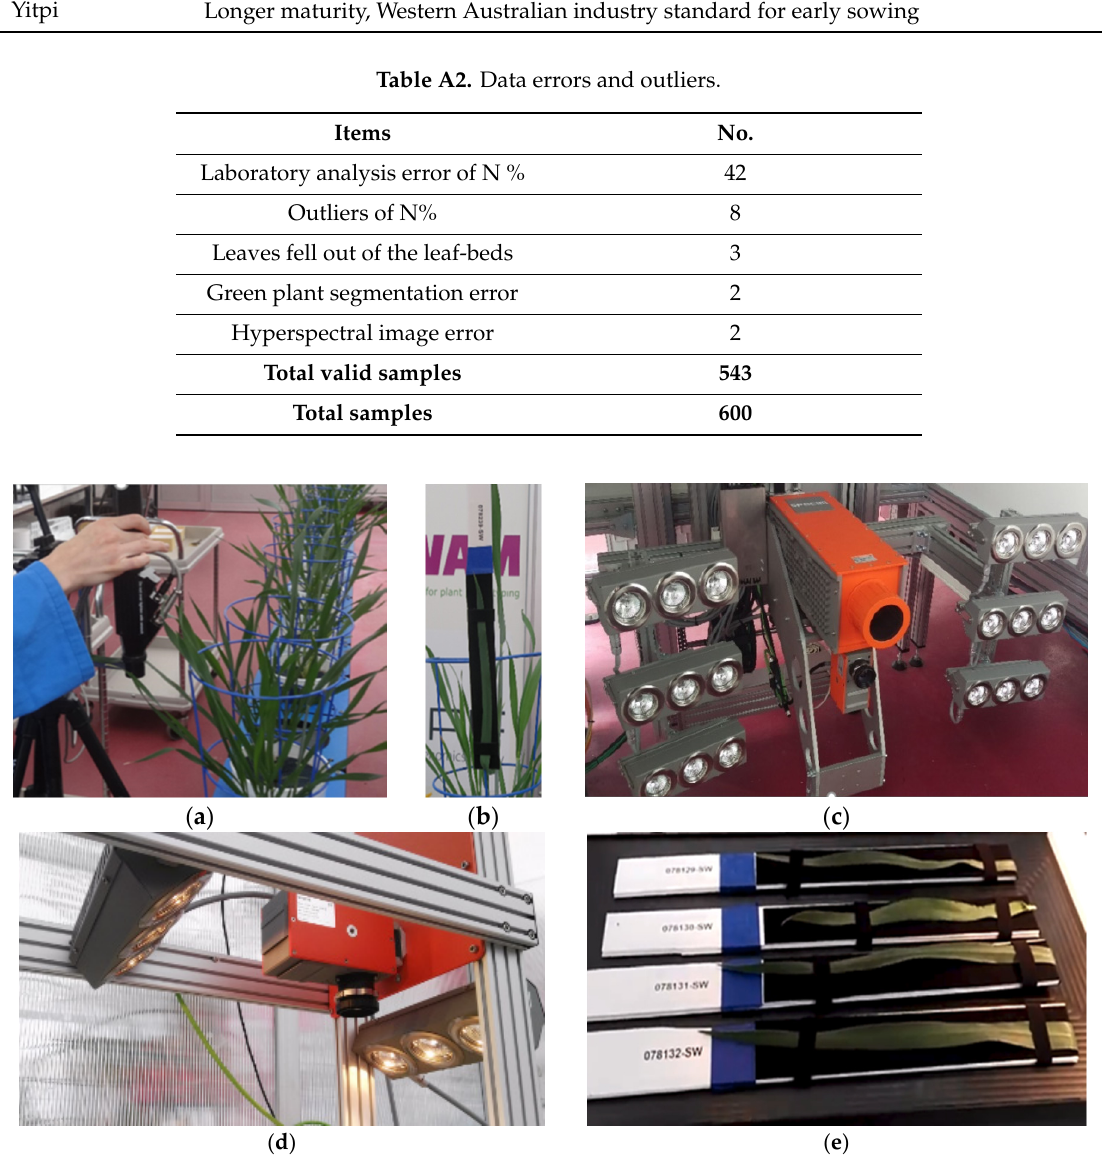
Figure A1. Data collection. ( a ) Data collection using the ASD Spec 3 spectrometer. ( b ) A wheat leaf bound to a leaf ‐ bed for imaging. ( c ) The system set up of the hyperspectral imaging system in the phenotyping platform. The larger camera on the top is the SWIR camera and the smaller camera on the bottom is the FX10 camera. ( d ) The system set up of the labscanner using the FX10 camera. ( e ) The leaves bound to the leaf ‐ beds and laid on the conveying tray of the labscanner for imaging.